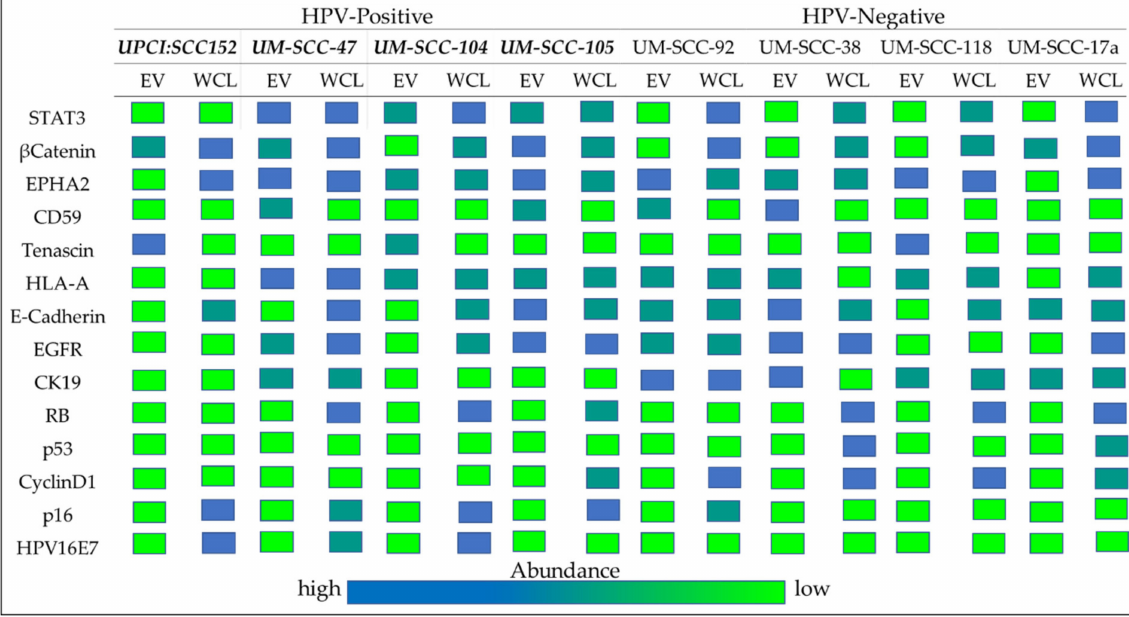
Figure 9. Relative abundance of the selected proteins detected by Wes protein analysis in EVs and WCL from HNSCC cell lines, by HPV status. Bold italics: